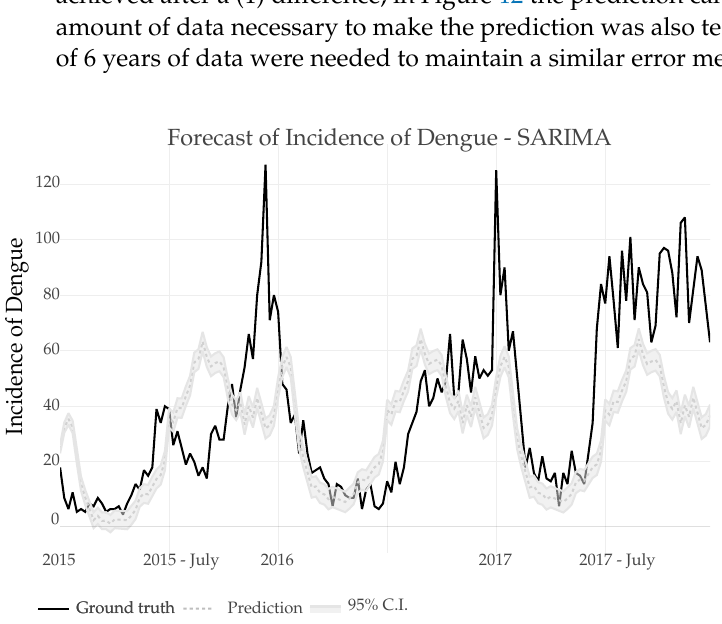
Figure 12. Prediction of Dengue Incidence for 3 years using a SARIMA model and comparison with the real number of